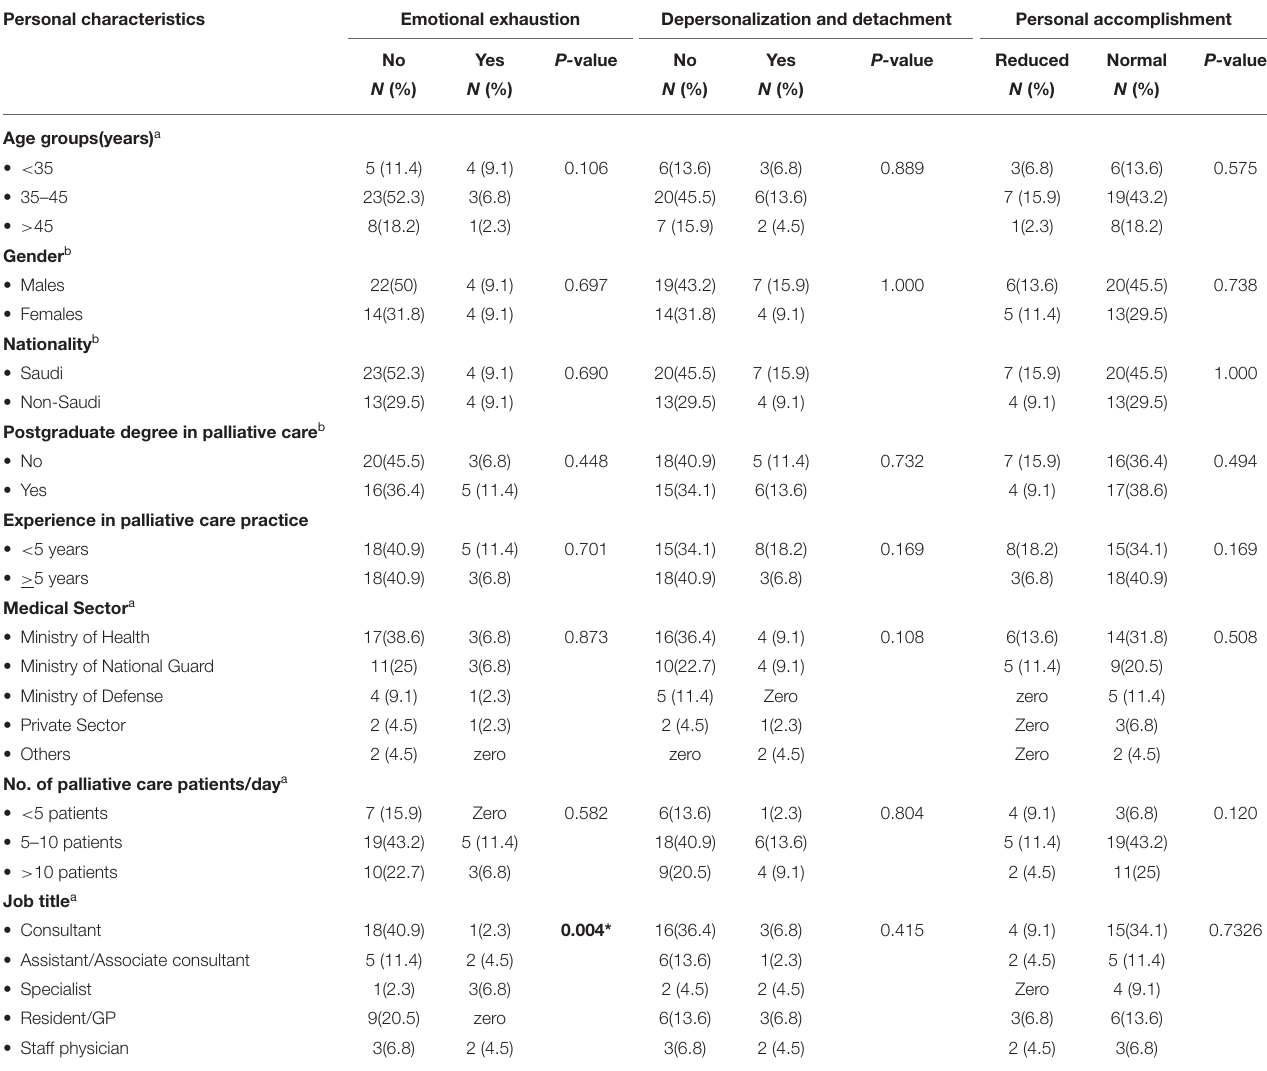
TABLE 3 | Relationship between participant’s personal characteristics with emotional exhaustion, depersonalization and personal accomplishment. Personal characteristics Emotional exhaustion Depersonalization and detachment Personal